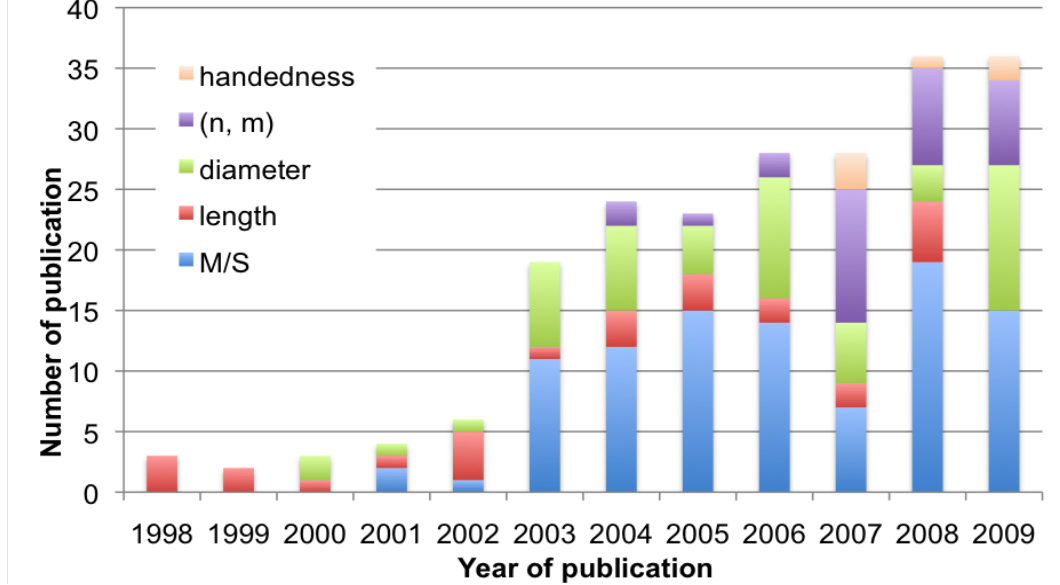
Figure 5. Annual change in number of publications in the following targeted objects to be separated; M/S, length, diameter, ( n , m ) and handedness.